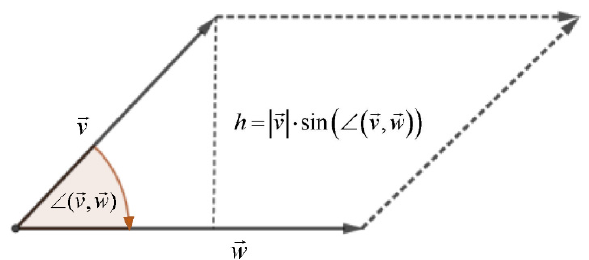
Figure 16. Geometric interpretation of the vector product of two vectors.